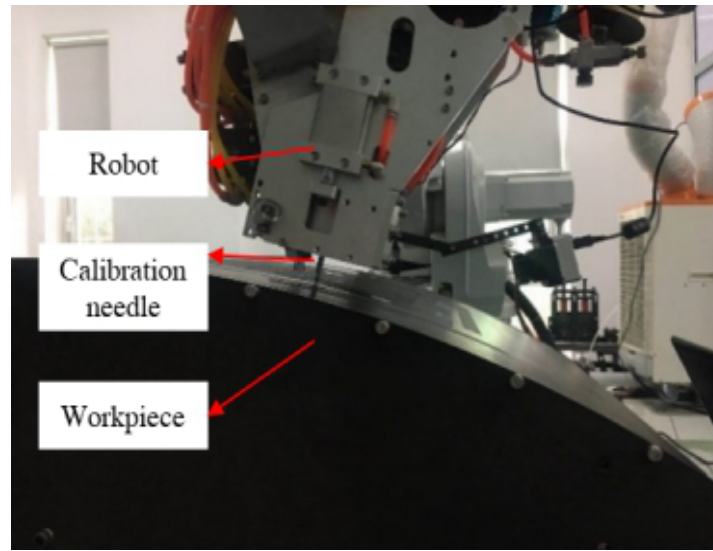
Figure 8. Position measurement. Figure 8. Position Table 2. Position measurement results of two methods.